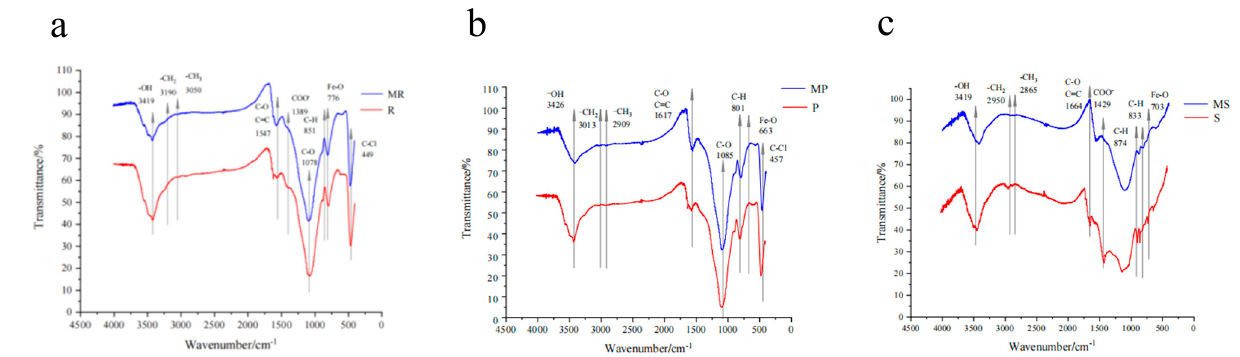
Figure 3. FTIR spectra of the unmodified biochars and MR ( a ), MP ( b ), and MS ( c ).